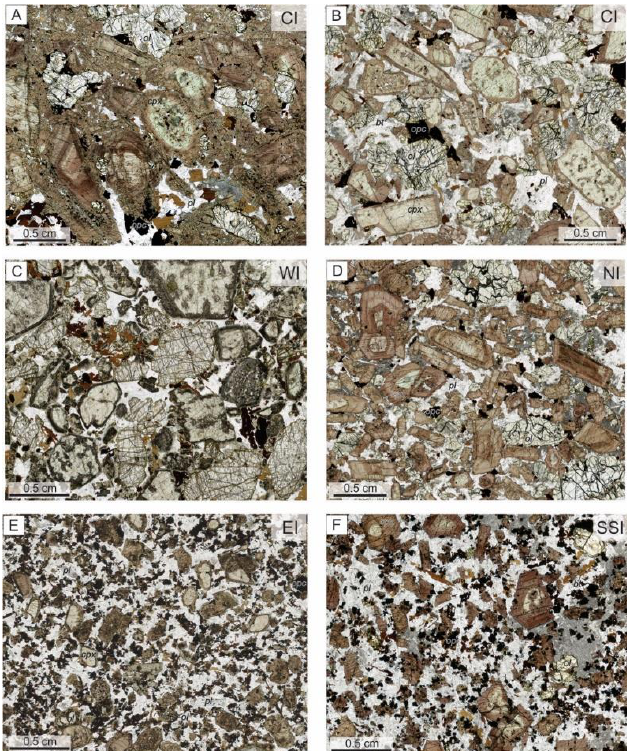
Figure 2. Petrographic aspects of the main intrusions of the Ponte Nova mafic–ultramafic alkaline massif in plan-polarized light. ( A – D ) Typical cumulate texture for the main cumulate intrusions, defined mainly by clinopyroxene and olivine primocrysts, with clinopyroxene as the main phase. ( E , F ) Porphyritic and inequigranular textures found in EI and SSI, with macrocryst population formed by clinopyroxene, subordinate olivine and minor plagioclase. Corrosion and sieve textures on complex step-zoned clinopyroxene cumulus crystals, with diopside relict cores (beige) and Ti-augite (brown) mantling and rims are found in all intrusions. Utilized mineral abbreviations: cpx, clinopyroxene; ol, olivine; opc, opaque minerals; pl, plagioclase; for additional abbreviations, see Figure 1.